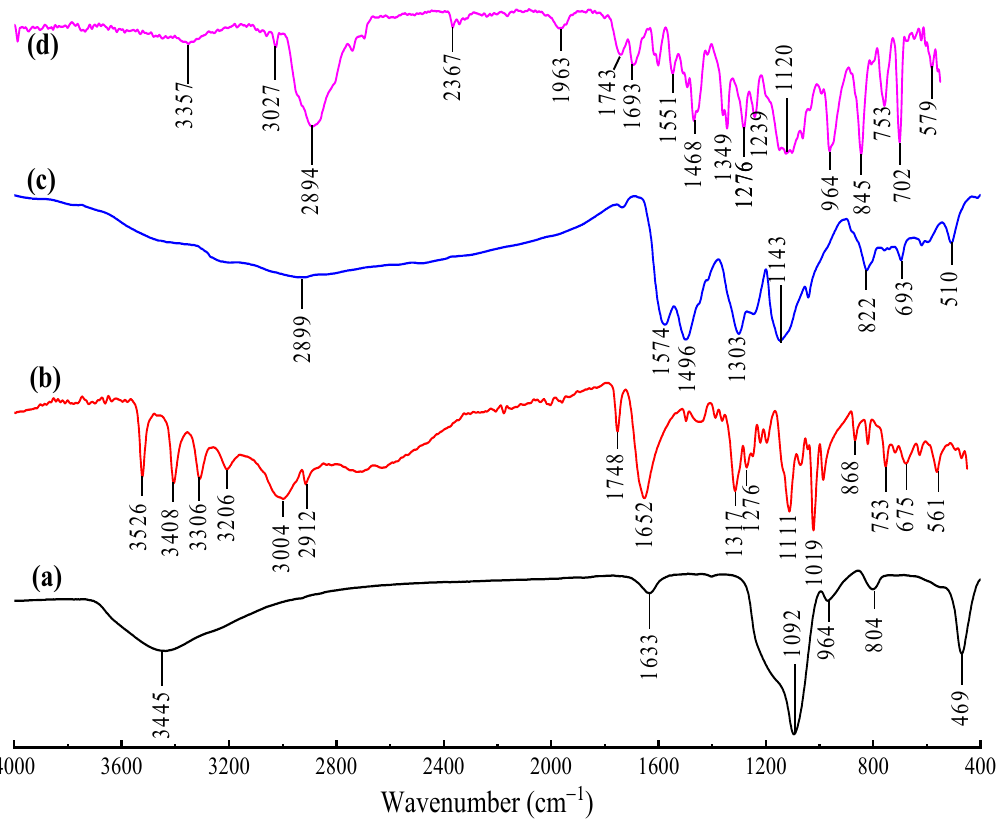
Figure 2. FTIR spectra of ( a ) calcined mesoporous silica nanoparticles (MSNs), ( b ) L-ascorbic acid, ( c ) pure PAni and ( d ) AS-g-PAni@MS nanocomposite. Figure 3 represents the XRD spectra of MSNs (black line) and AS-g-PAni@MS (blue line) in the 2 θ range of 5–80°. As can be seen from Figure 3 (black line), the XRD spectra of MSNs show the characteristics peaks at 2 θ value of 5.80° and 22.12° [14], while the XRD of the spectra represents the characteristics peaks of both MSNs and PAni at 6.31° (MSNs) and 20.09°, 25.69° for periodicity parallel and perpendicular to PANI chains. Moreover, a broad peak at 2 θ = 25.69 indicates the characteristic distance between the ring planes of the benzene ring to the adjacent chains [56]. The XRD spectra indicate the more or less amorphous nature in the material due to the presence of AS-g-PAni polymer blend, which reduces the intensity of the peaks. More information about the crystallite size can be obtained by using the Scherrer equation, as given by Equation (19) [57]: